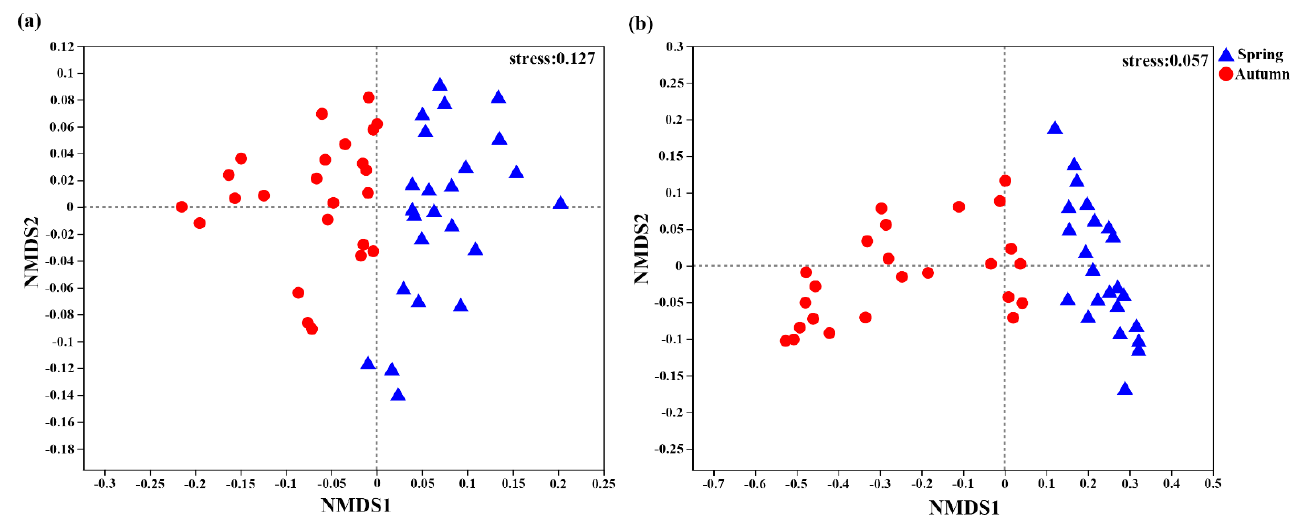
Figure 4. Nonmetric multidimensional scaling (NMDS) based on Bray–Curtis distances at the operational taxonomic unit (OTU) level of soil AOA ( a ) and AOB ( b ) communities in spring and autumn.